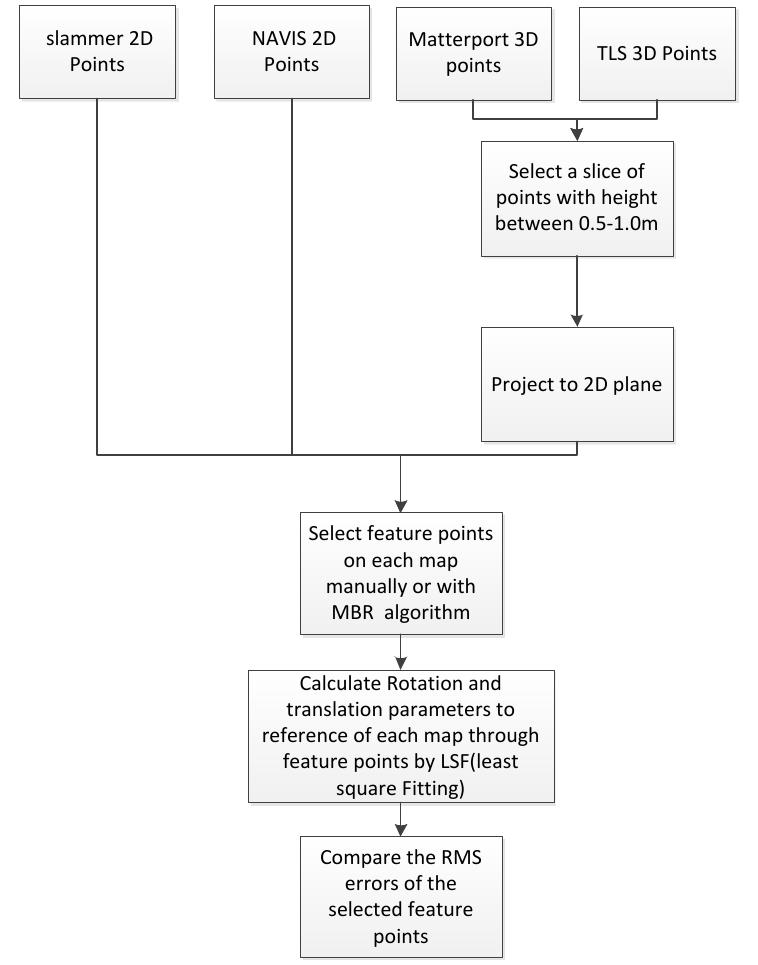
Figure 5. Data process flow for accuracy comparison.